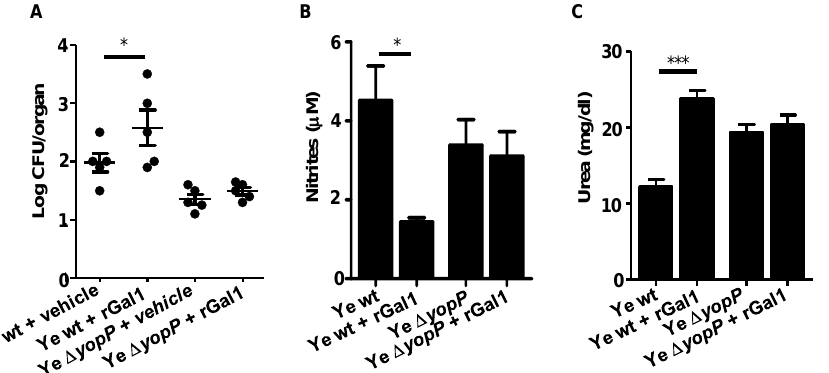
Figure 6. Exogenous Supplementation of rGal1 does not Revert the Protective Anti–Ye Response Observed in the Absence of YopP . Lgals1 −/− mice were treated i.p. with rGal1 or vehicle control daily for 5 d, starting on the day of infection. Mice were euthanized at day 5, and CFU were determined in homogenates of PPs. Limit of detectable CFU was 25 (log 10 25 = 1.4) ( A ). Lgals1 −/− macrophages were infected with Ye wt or Ye ∆ yopP for 1 h in the presence or absence of rGal1. NO production was determined in supernatants using Griess assay ( B ). Urea was determined in culture supernatants as an indirect evaluation of arginase activity ( C ). Data are representative of two independent experiments ( n = 5 mice per group) ( A ). Data are mean ± SEM of two independent experiments ( B , C ). * p < 0.05, *** p < 0.001.